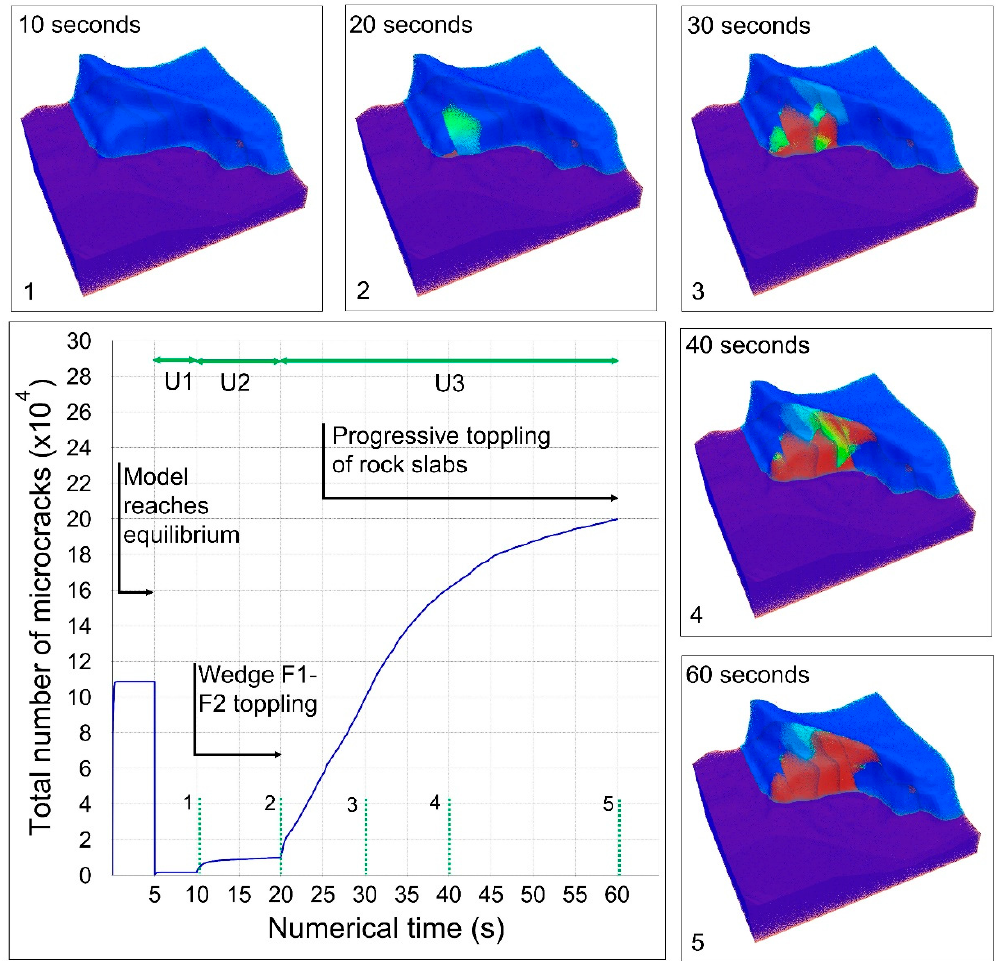
Figure 13. Summary of the numerical modelling results obtained using Slope Model. The graph of total microcrack number vs. numerical time shows the progressive increase in cracking (spring failure) within the model. U1, U2, and U3 identify the three simulated undermining stages. 1 – 5 identify the model states represented in boxes 1–5. Note that during undermining stage U2, the failure of wedge F1–F2 coincides with a low increase in microcrack count, whereas brittle damage accumulates with the progressive toppling of rock slabs.